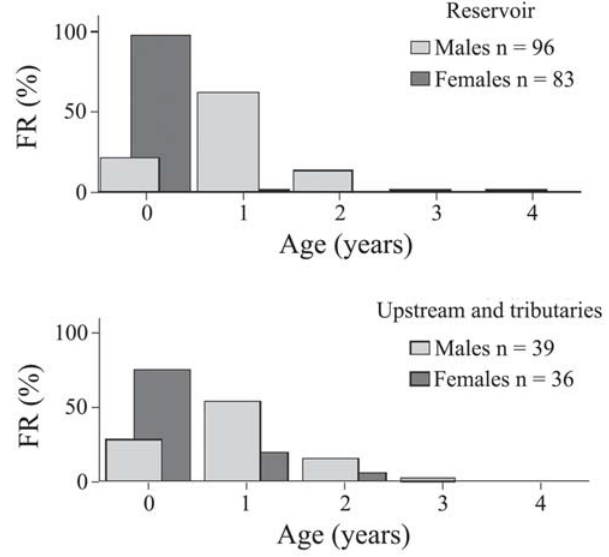
Fig. 3. Frequency per age (years) of Salminus brasiliensis individuals from Corumbá Reservoir, upstream and